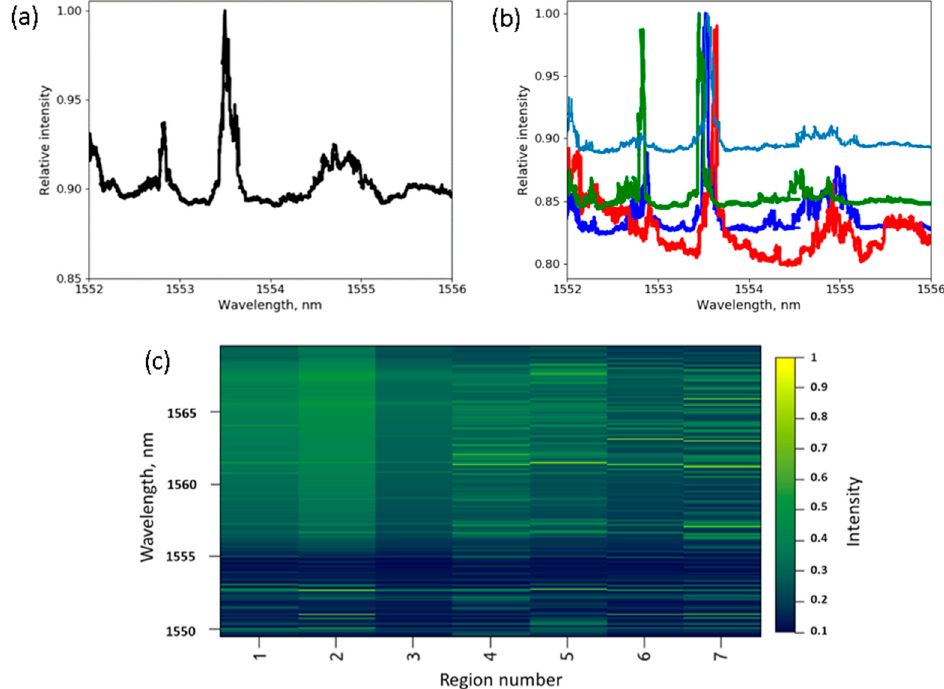
Figure 5. Experimental data of scattered light from a single microsphere. A small section of the light intensity pattern from: ( a ) analyzing one PMMA microsphere; ( b ) dividing the same PMMA microsphere into seven regions. Four of the seven regions have been plotted to show differences between them; ( c ) mode map generated from different regions of one PMMA microsphere.